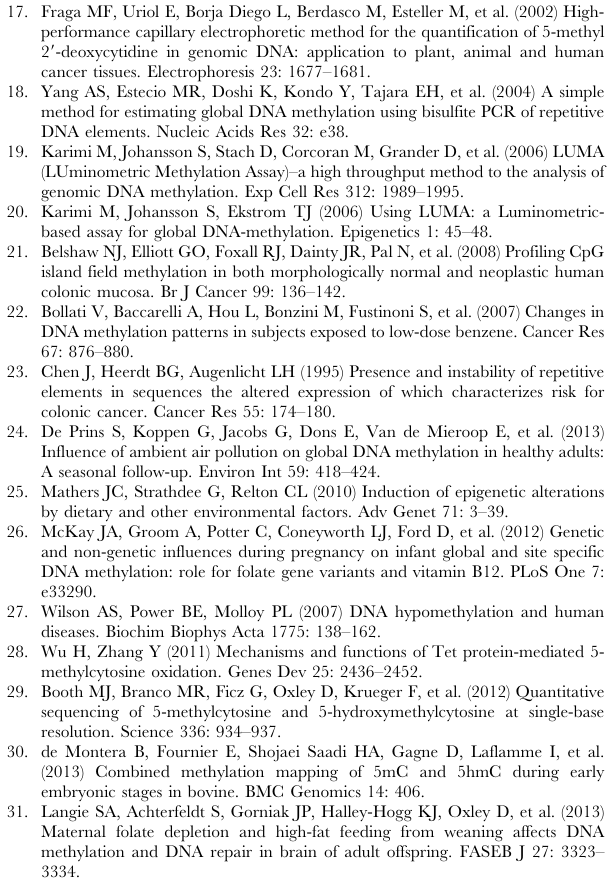
Figure S1 Validation curve for EcoR I incubated for 4 h in 1x Tango buffer with 0, 25, 50, 75, and 100% methylated Lambda DNA (A); Star activity was observed for EcoR I in 1x Tango buffer, but not in 2x Tango buffer when incubated for 4 h with methylated Lambda DNA (B); Validation curve for Mun I incubated with 0, 25, 50, 75, and 100% methylated Lambda DNA for 4 h or 16 h (C); in 1x Tango buffer; and E) Patterns of digested unmethylated and methylated Lambda DNA for 4 h in 1x Tango buffer with EcoR I or Mun I, showing impaired cleavage of EcoR I on methylated Lambda DNA